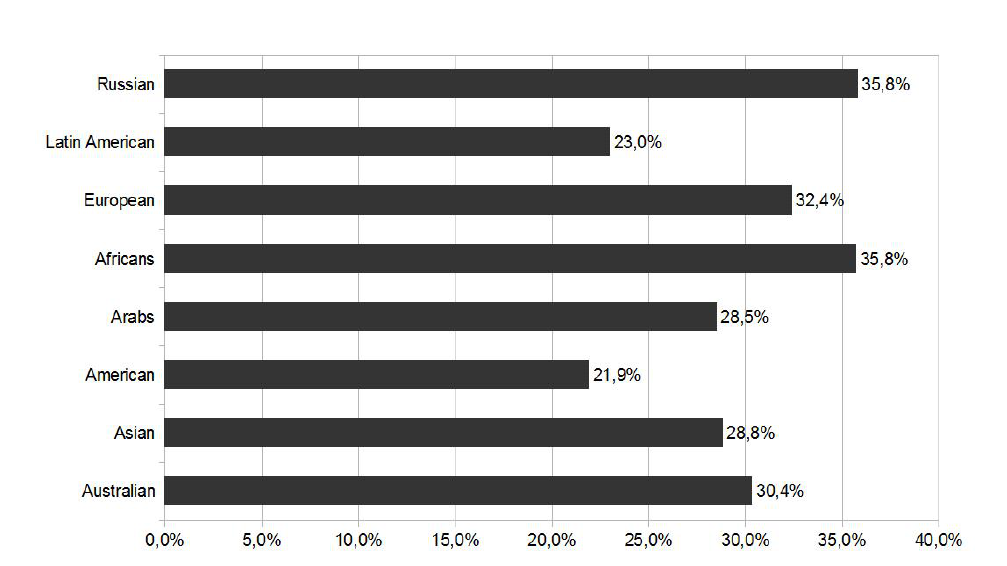
Figure 3. Share of bought-in paintings by the artist’s nationality.